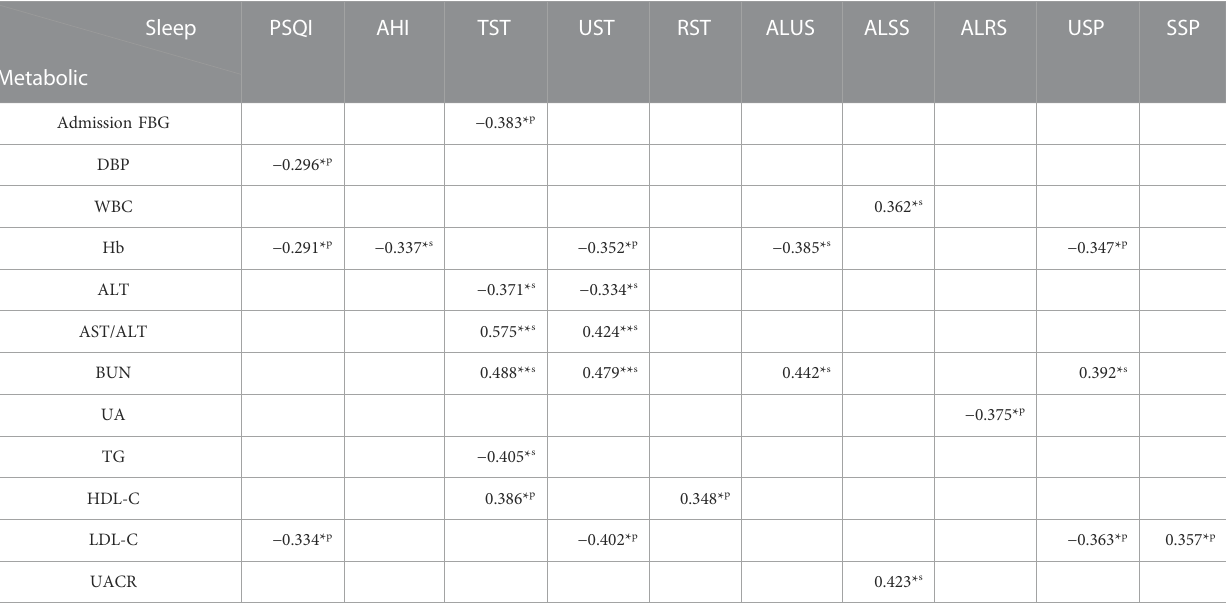
TABLE 3 Correlation coef fi cients between sleep quality metrics and clinical metabolic